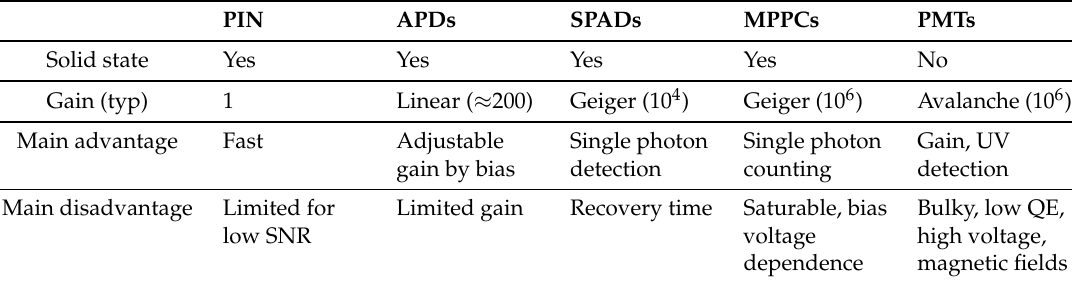
Table 4. Summary: main features of photodetectors for